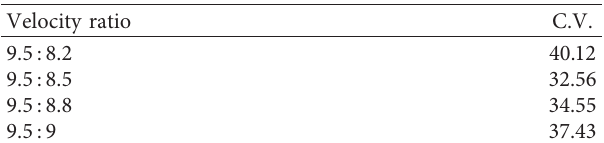
Table 3: C.V. of the crystals with different velocity ratios of oil and aqueous phases.